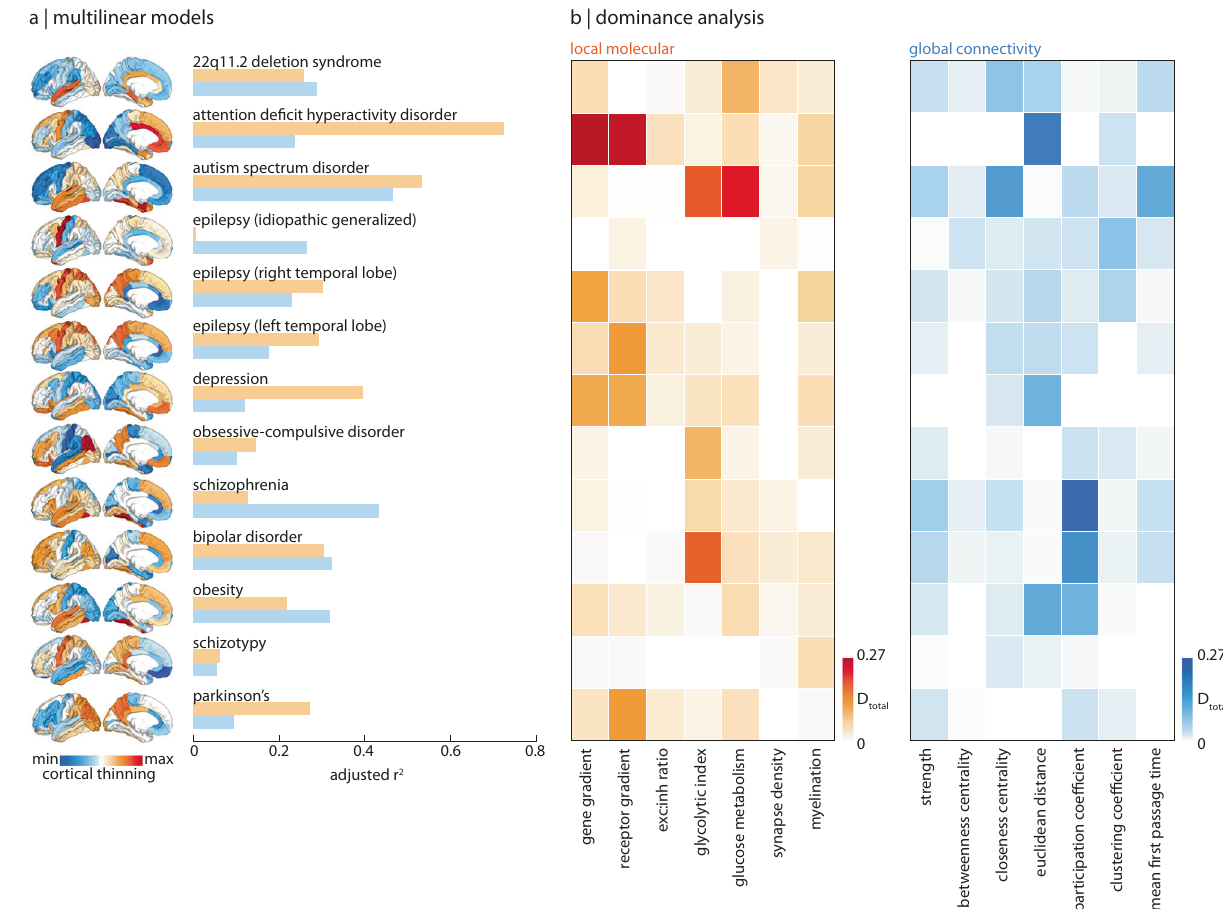
molecular; blue: connectivity). b Dominance analysis was applied to assess the contribution of each input variable (done separately for molecular (orange) and connectivity (blue) predictors) to the fi t of the